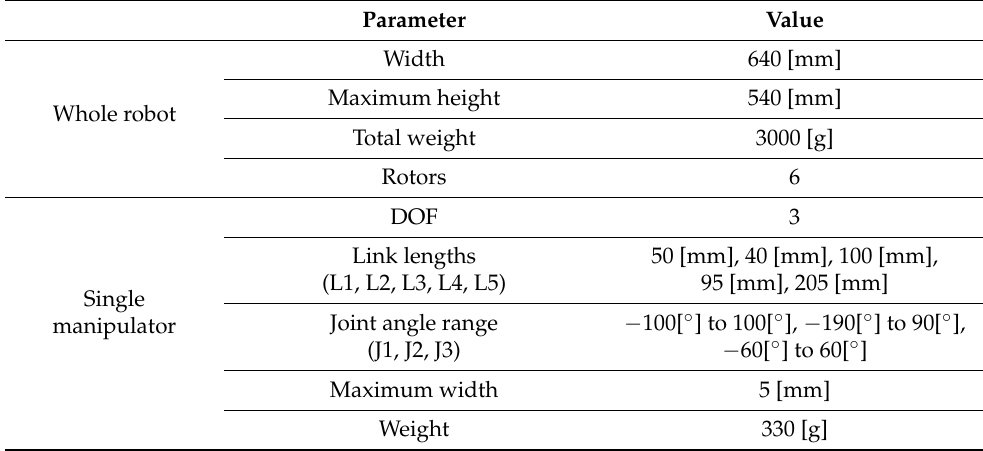
Table 1. Parameters of the whole robot and three-arm aerial manipulator system with parallel link